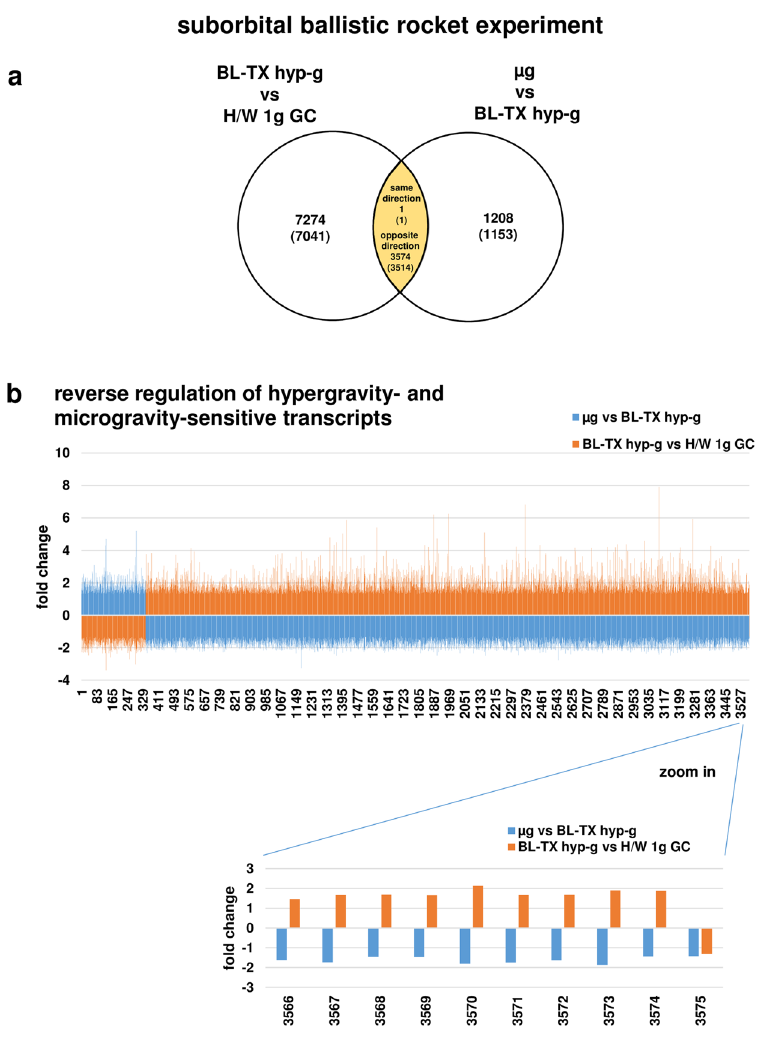
Figure 6. Hyper- and microgravity-double-sensitive transcripts are reversely regulated in the TEXUS-49 suborbital ballistic rocket campaign. ( a ) Venn diagram showing 3575 hyper- and microgravity-double-sensitive transcripts (3515 annotated transcripts). ( b ) Graphical display of 3575 transcripts of the intersection, including one single transcript that is regulated in the same direction. Fold changes (FCs) are ratios between the averages of linear expression values. If the ratio is < 1, FC is calculated as the negative reciprocal of the